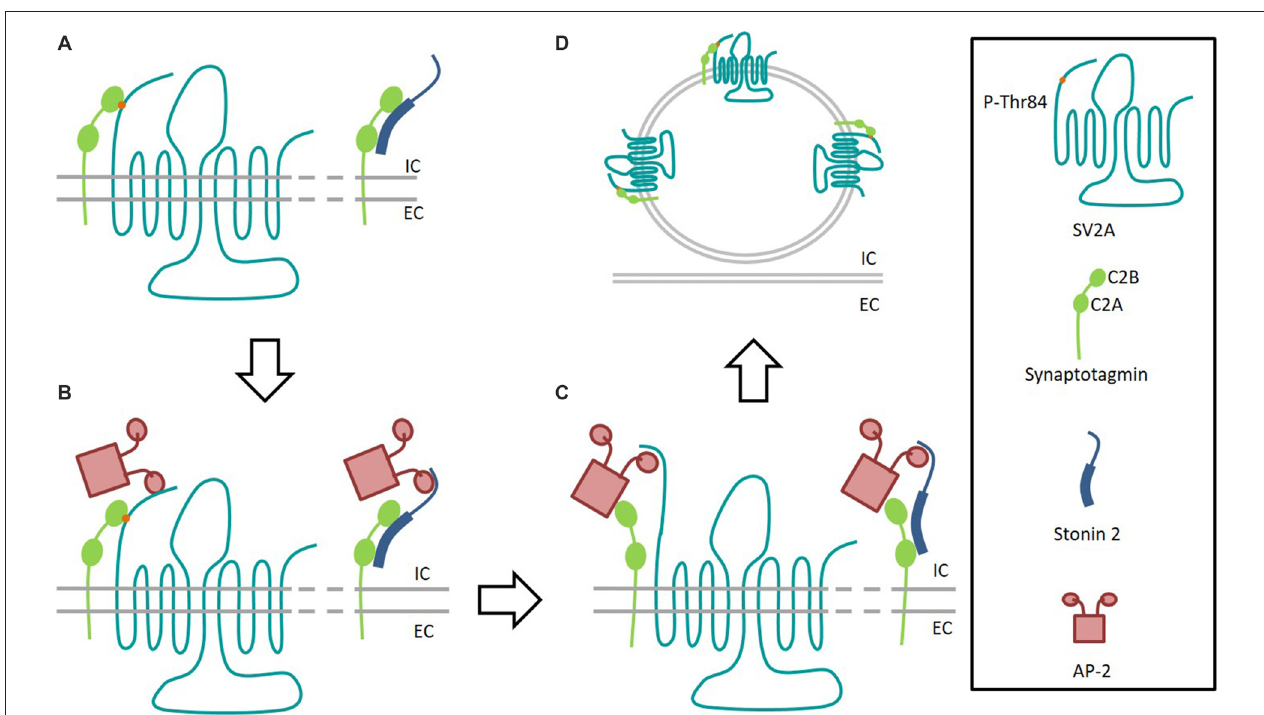
FIGURE 3 | Interaction model of SV2A and Stonin 2 with Synaptotagmin 1. (A) After fusion event, the C2B domain of Synaptotagmin 1 (green) interacts with SV2A (light blue) phosphorylated-T84 residue (orange) and Stonin 2 (dark blue) binds to both C2 domains of Synaptotagmin to initiate recycling. (B) SV2A and Stonin 2 bind to AP-2 (pink) to facilitate the formation of the endocytosis complex. (C) Synaptotagmin 1 binds to AP-2. Dephosphorylated SV2A keeps interaction with AP-2 to consolidate the endocytosis complex. (D) After endocytosis, the fusion competent vesicle presents Synaptotagmin 1 bond again to T84-phosphorylated SV2A. IC, Intracellular; EC,